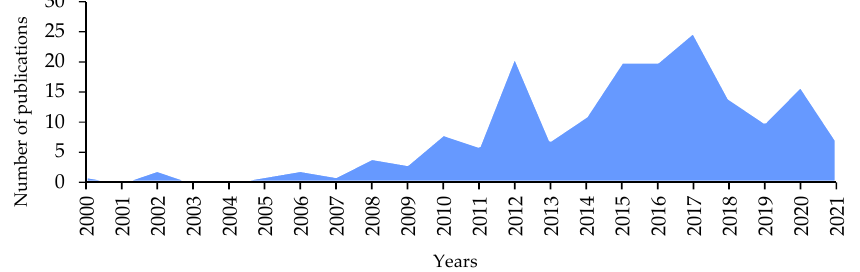
Figure 1. Temporal analysis of papers concerned with economic analysis of perennial crops for energy.